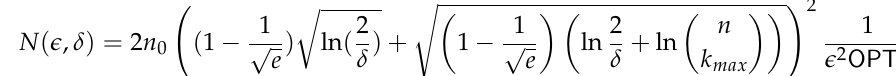
√ Algorithm 5 returns a ( 1 − 1/ e − (cid:101) )-approximation solution with probability at least 1 − δ